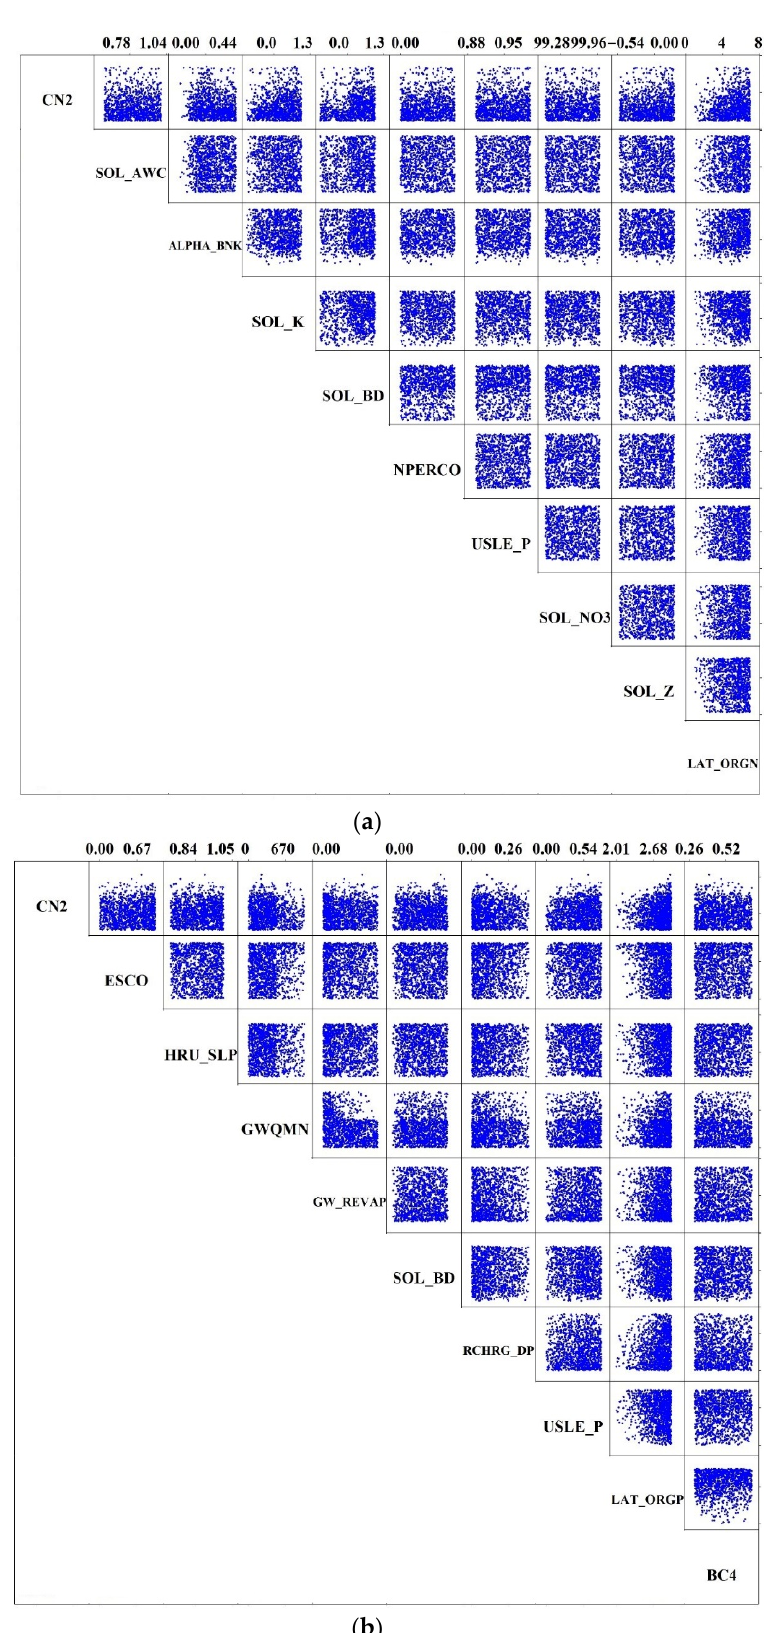
Figure 5. Behavior parameter correlation graph of ( a ) the total nitrogen load and ( b ) the total phosphorus load with the GLUE method (20,000 runs).